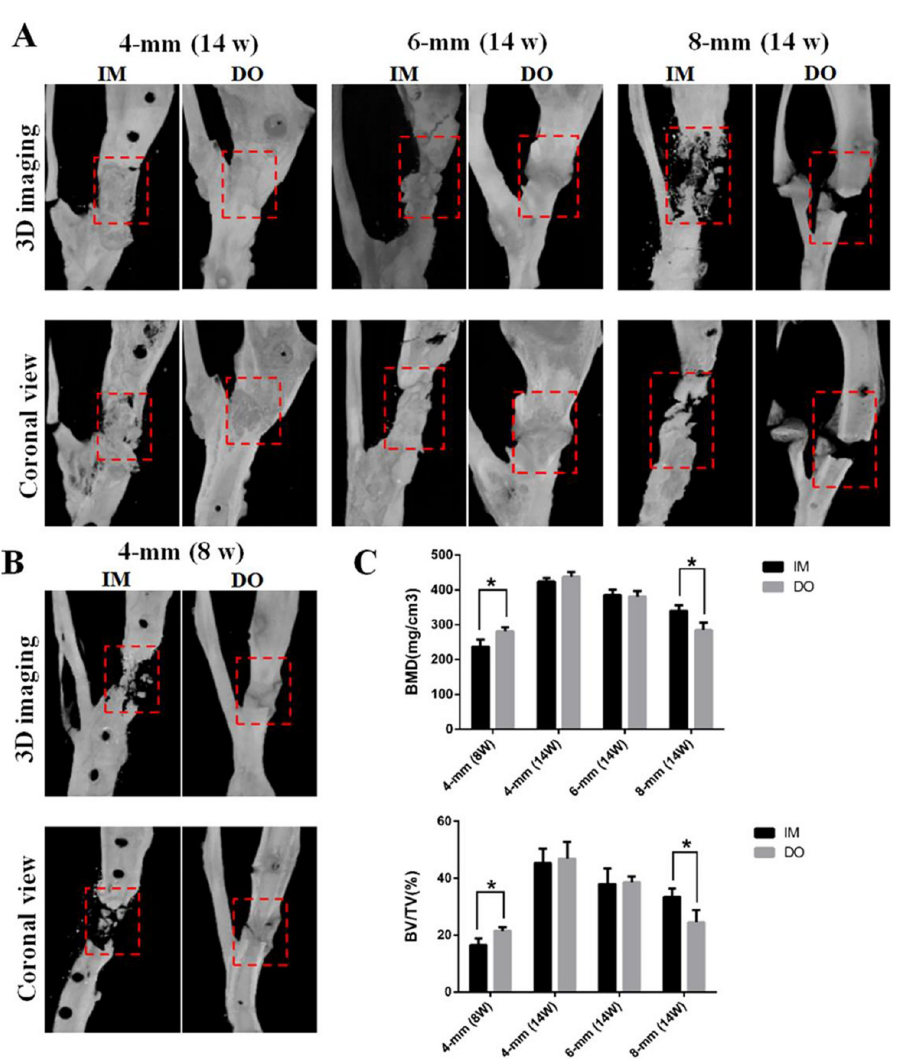
Fig 3. Representative micro-CT images of bone repair in the three groups. (A) Three-(top panel) and two- dimensional (lower panel) reconstructed images of bone defects at 14 weeks after surgery. Red dotted boxes indicate region of interest (ROI), representing bone defect areas. (B) Three- (left panel) and two-dimensional (right panel) reconstructed images of bone defects in 4-mm group at 8 weeks post-operation. (C) Quantification of bone mineral density (BMD), bone tissue volume/total tissue volume and (BV/TV) insides defect regions. ( � P < 0.05; NS: not significant).